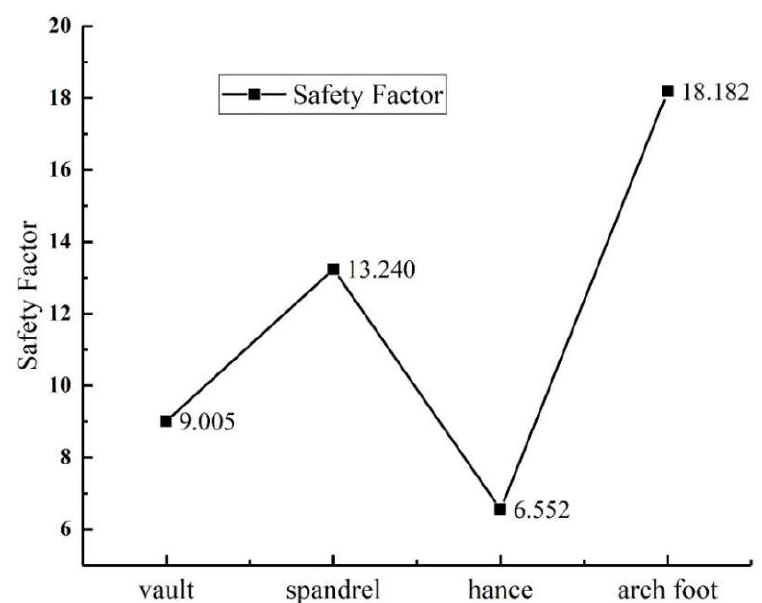
Figure 17. Variation law of axial force and bending moment with void location.